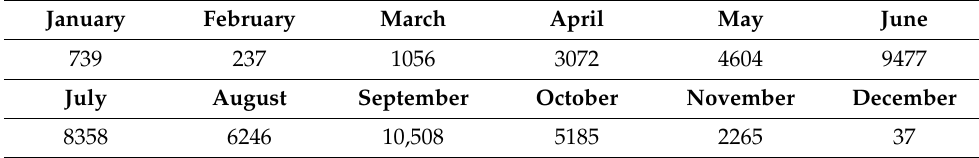
Table 6. Forecasting results for 12 periods of 2021 by Holt’s exponential smoothing